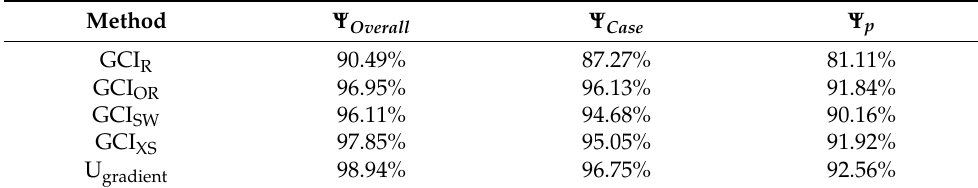
Table 2. Result of the Accuracy